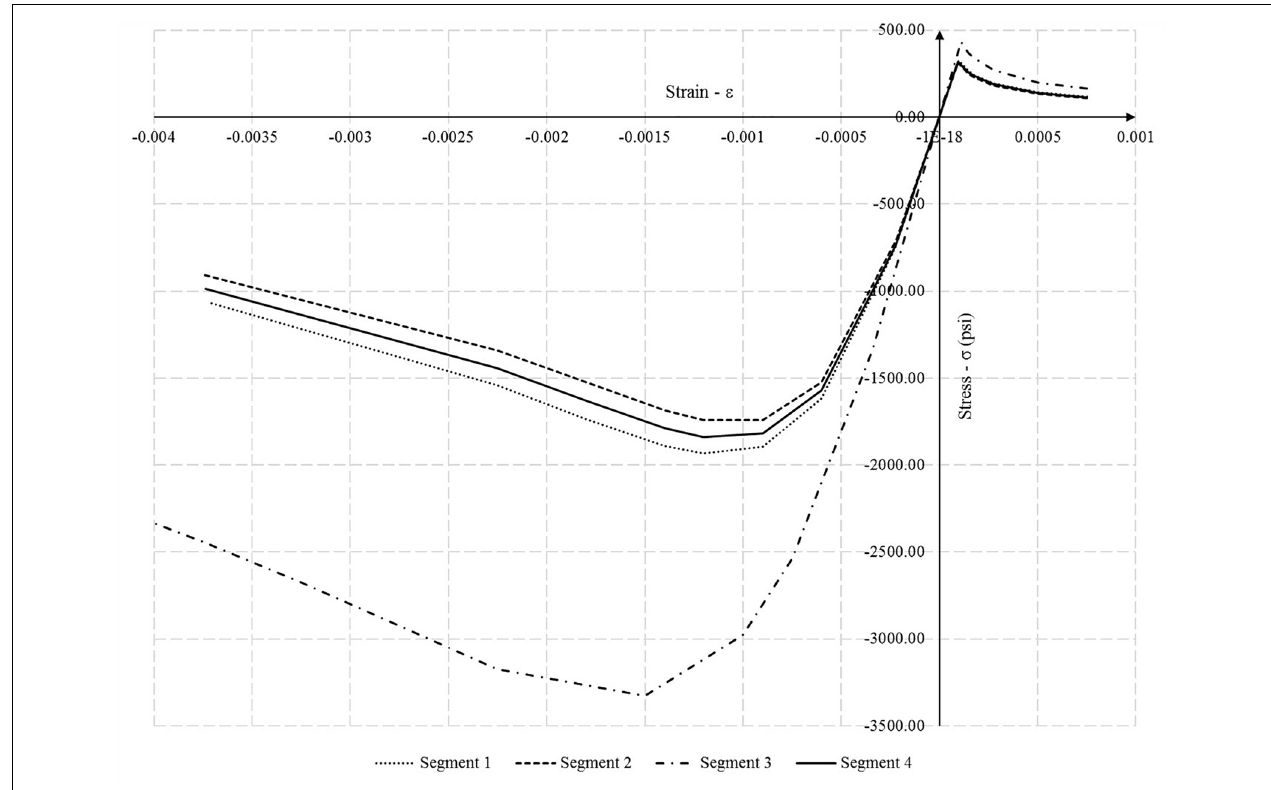
FIGURE 8 | FEM input Stress-strain curves for segments 1–4 (100 psi = 0.69 MPa).